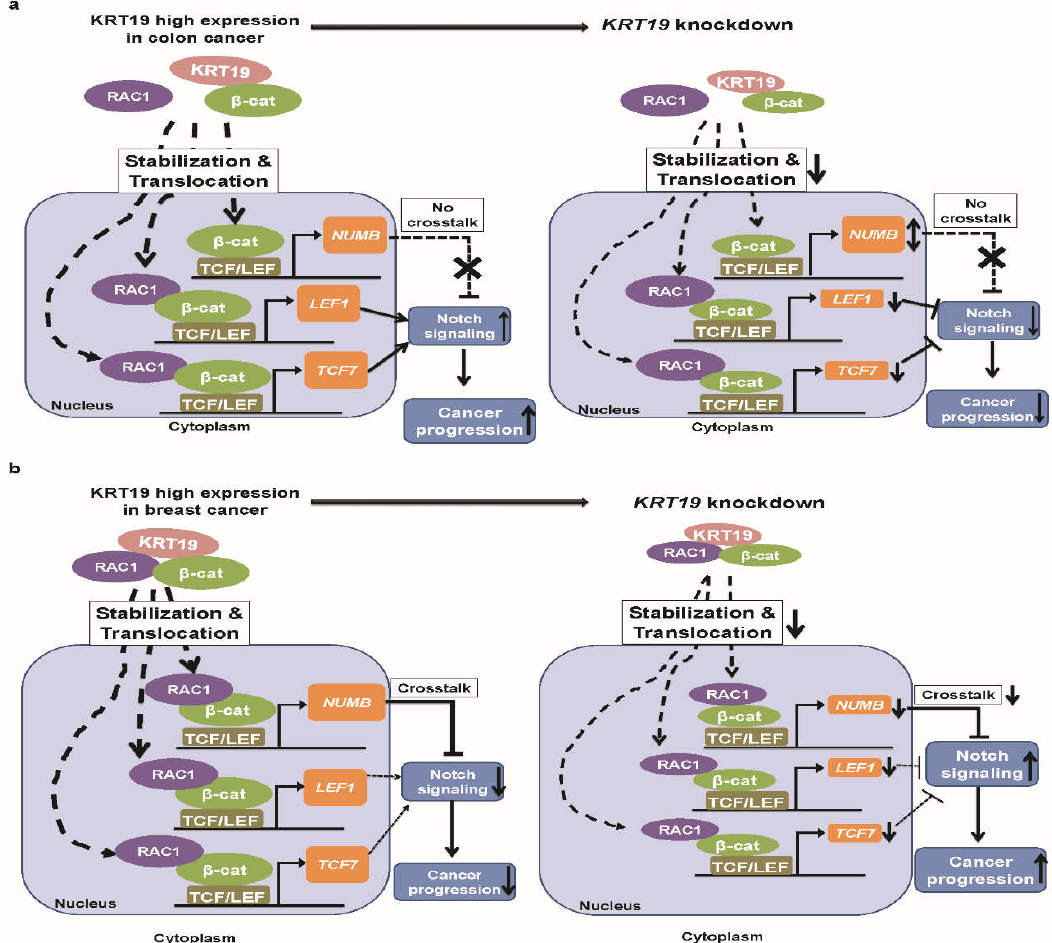
Figure 6. Schematic diagram of the molecular function of KRT19 as a regulator of cancer properties through differential modulation of the Wnt/ β -catenin/Notch signaling pathway in colon and breast cancers. KRT19 directly interacts with only β -catenin to regulate Wnt/Notch signaling pathway and control cancer properties in colorectal cancer ( a ). KRT19 directly binds to the β -catenin/RAC1 complex to regulate NUMB transcriptional activity, which is an upstream inhibitor of the Notch signaling pathway and negatively regulates breast cancer properties ( b ).